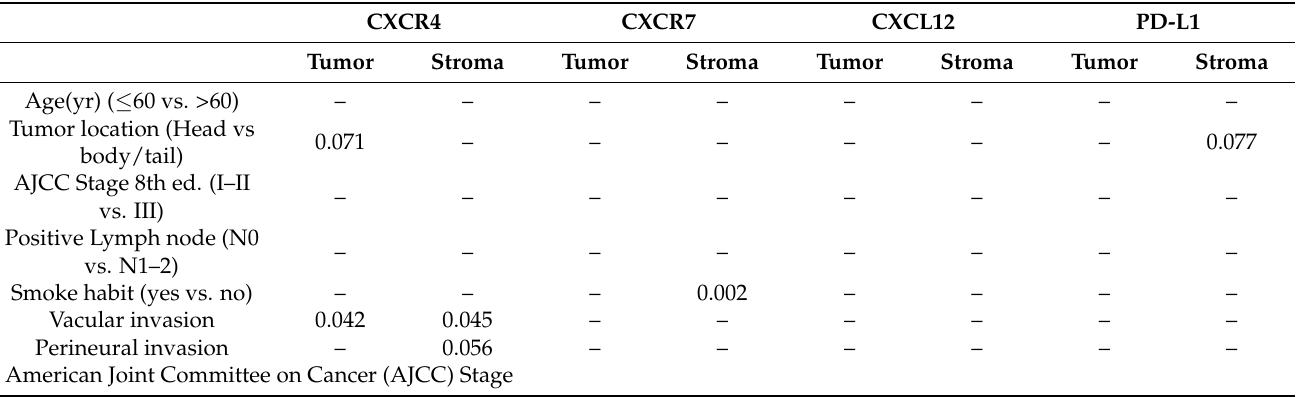
Table 3. CXCR4, CXCR7, CXCL12 and PD-L1 association with patient clinicopathological features.